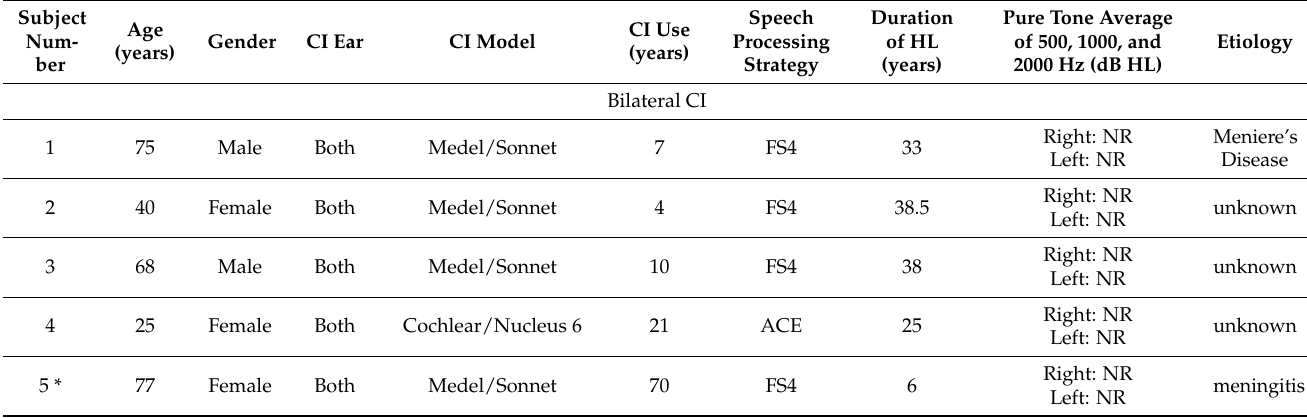
Table 1. Demographic information of CI